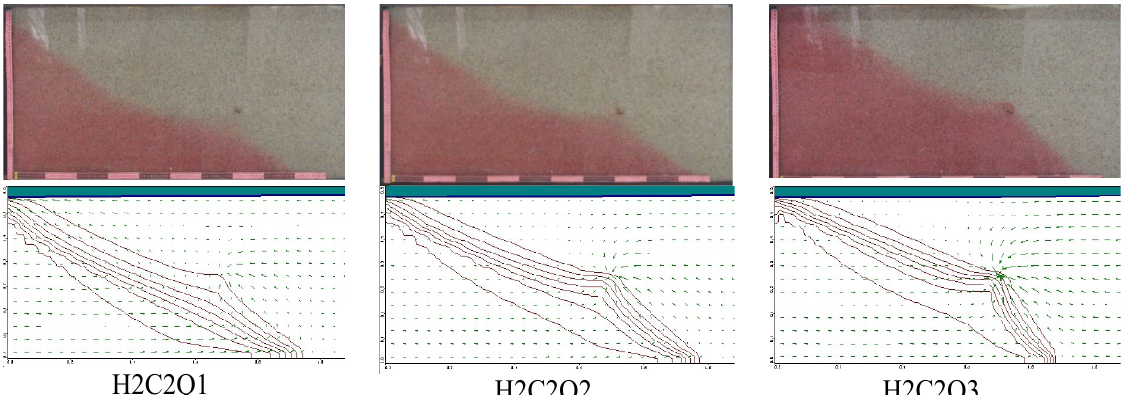
Fig. 4: Final steady state condition in three different extraction rates in H2C2 experiments